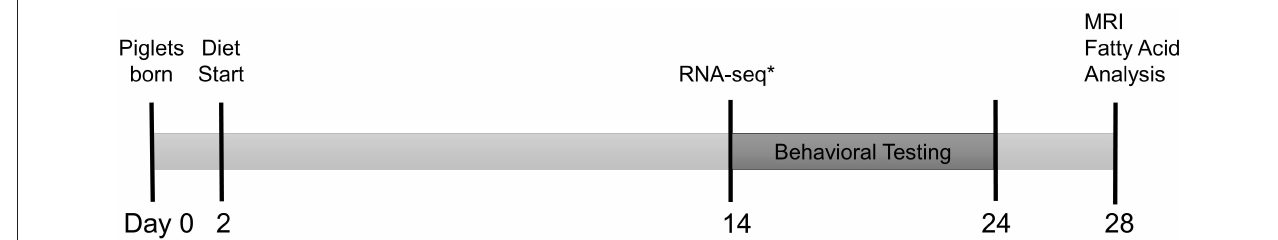
FIGURE 1 | Experimental timeline. Full term, naturally delivered, sex-matched littermate pairs of piglets ( n = 30 SGA, n = 30 AGA) were obtained from the University of Illinois Swine Farm at 2 days old and placed onto either CON or HF diet. Piglets began T-maze behavioral testing at 14–17 days old, tested for 9 days, and underwent magnetic resonance imaging (MRI) and tissue collection for hippocampal and cerebellar fatty acid analysis at 26–29 days old. *A separate cohort of identically raised piglets ( n = 6/group) were sacrificed at 14 days old for hippocampal RNA-sequencing. AGA, appropriate for gestational age; SGA, small for gestational age; CON, control; HF, hydrolyzed